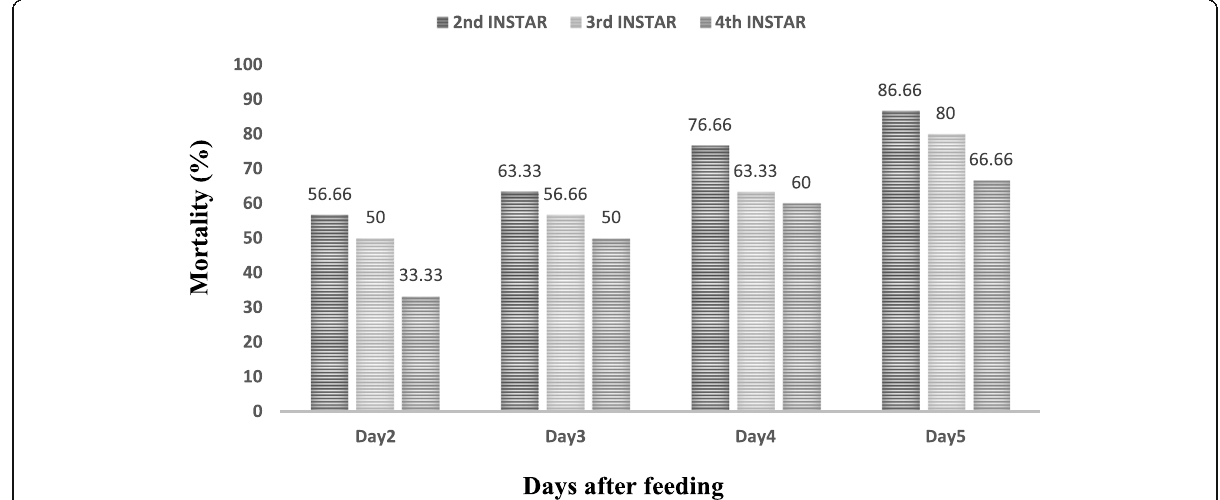
Fig. 1 Mortality of different Tuta absoluta larval instars caused by Cry1Ac at LC